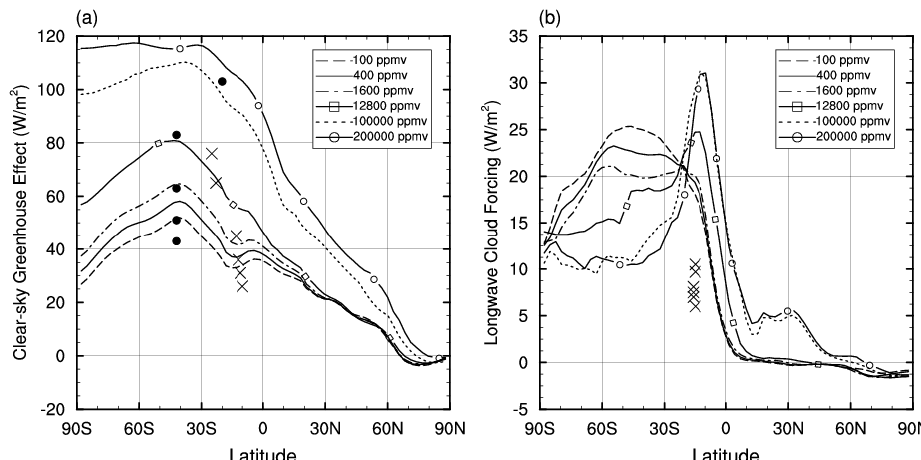
Fig. 2. January zonal-mean clear-sky greenhouse effect (a) and longwave cloud forcing (b) for various CO 2 levels. In Fig. 2a, black dots from the bottom to top denote the maximum clear-sky greenhouse effects and their latitudes in LMDZ, corresponding to 100, 330, 1600, 12800ppmv, and 0.1bar, respectively, and crosses indicate the maximum clear-sky greenhouse effects and their latitudes in FOAM, corresponding to 100, 400, 1600, 12800ppmv, 0.1, and 0.2bars, respectively. Crosses in Fig. 2b marks the maximum longwave cloud forcing for various CO 2 levels in FOAM.